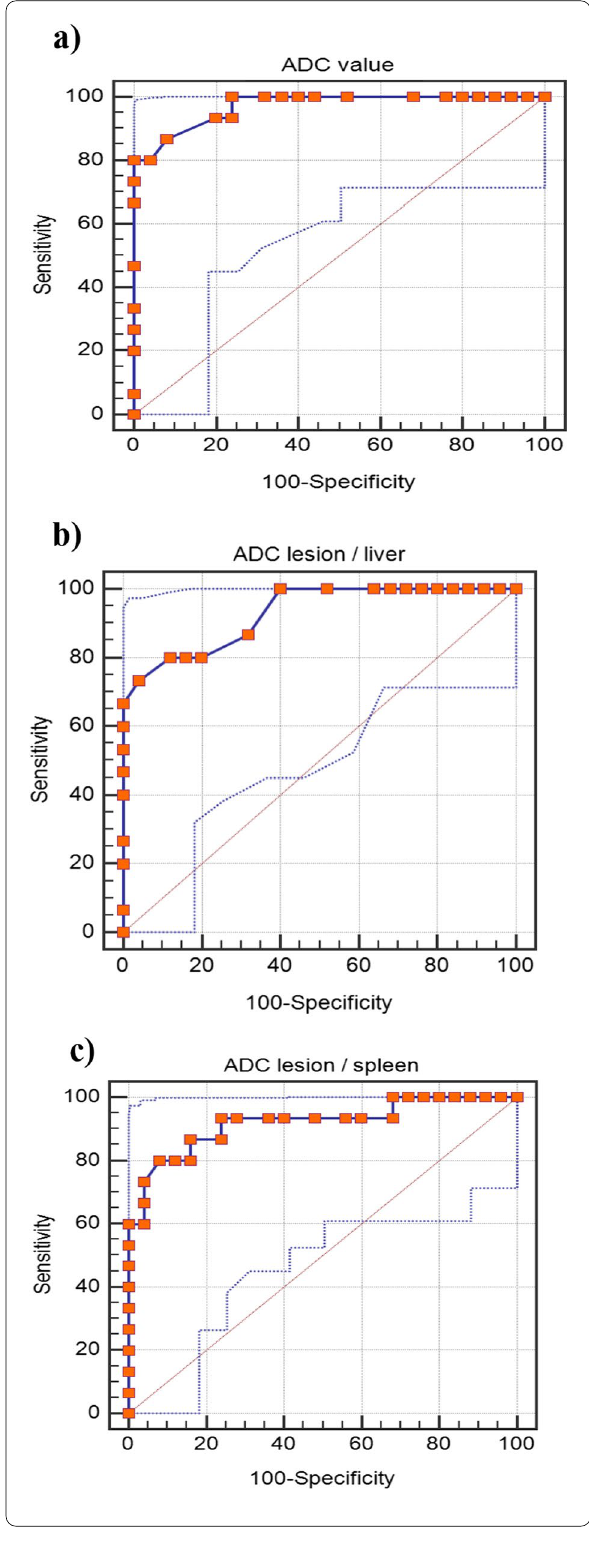
Fig. 5 a Receiver operating characteristic (ROC) curve of ADC.